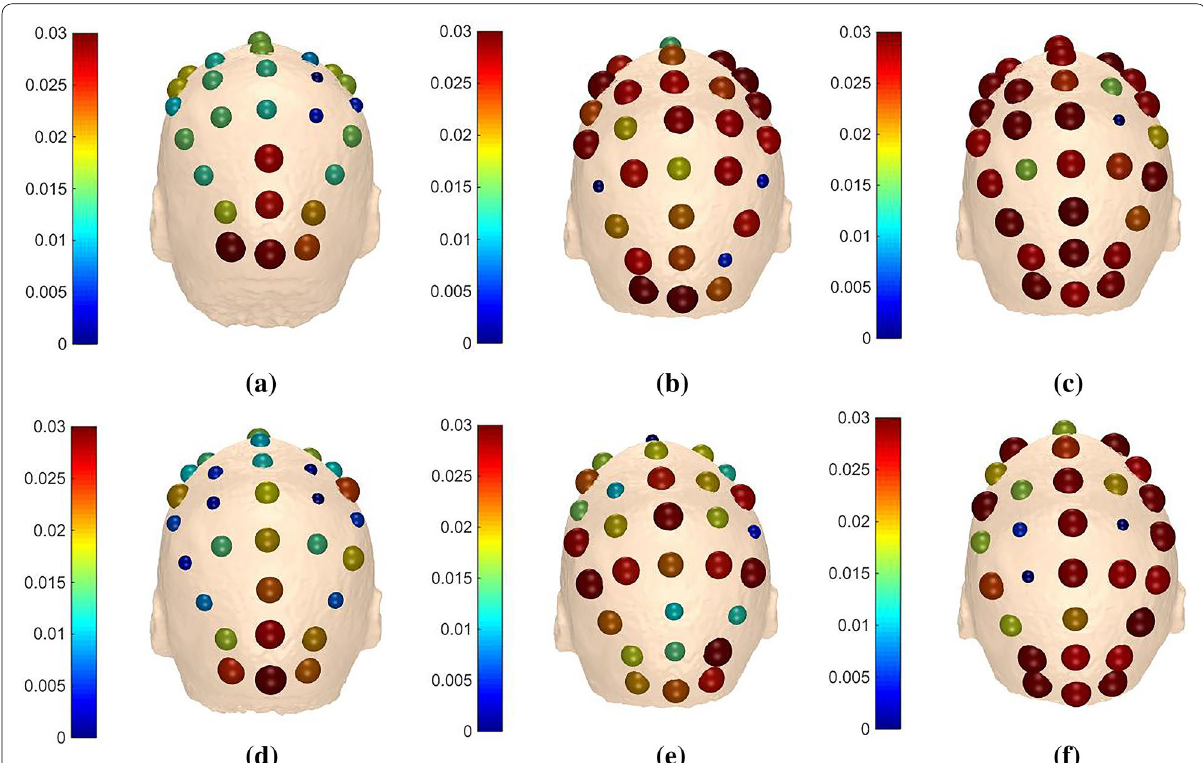
1 for ‘LH’ task, b m =